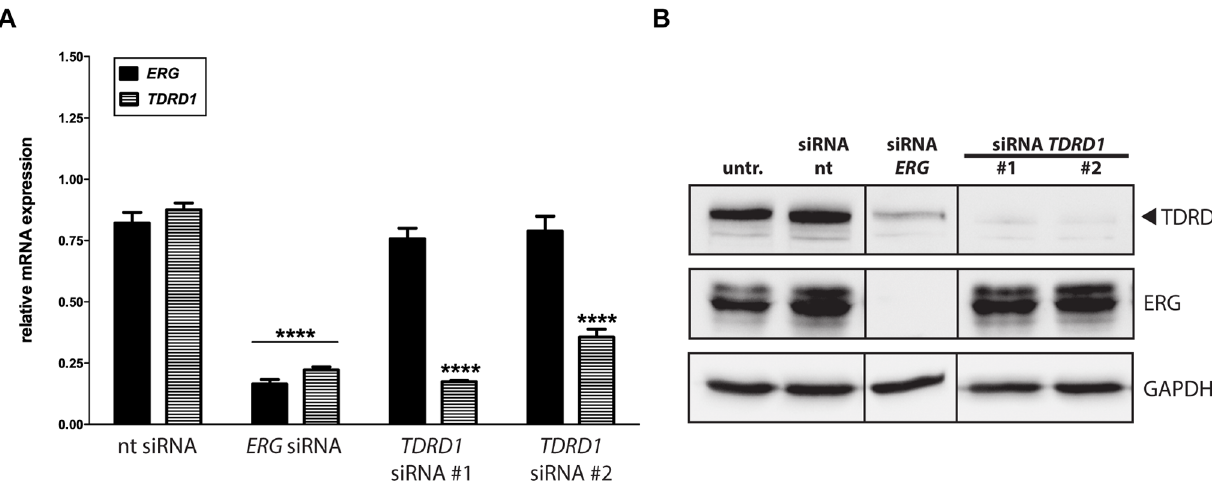
Figure 2. ERG transcription factor is required to maintain high TDRD1 expression. (A) ERG and TDRD1 mRNA expression levels in VCaP cells measured 72 h after gene silencing with siRNAs. Three independent experiments were performed in triplicate. (B) ERG and TDRD1 protein expression in VCaP cells 72 h after gene silencing with siRNAs.